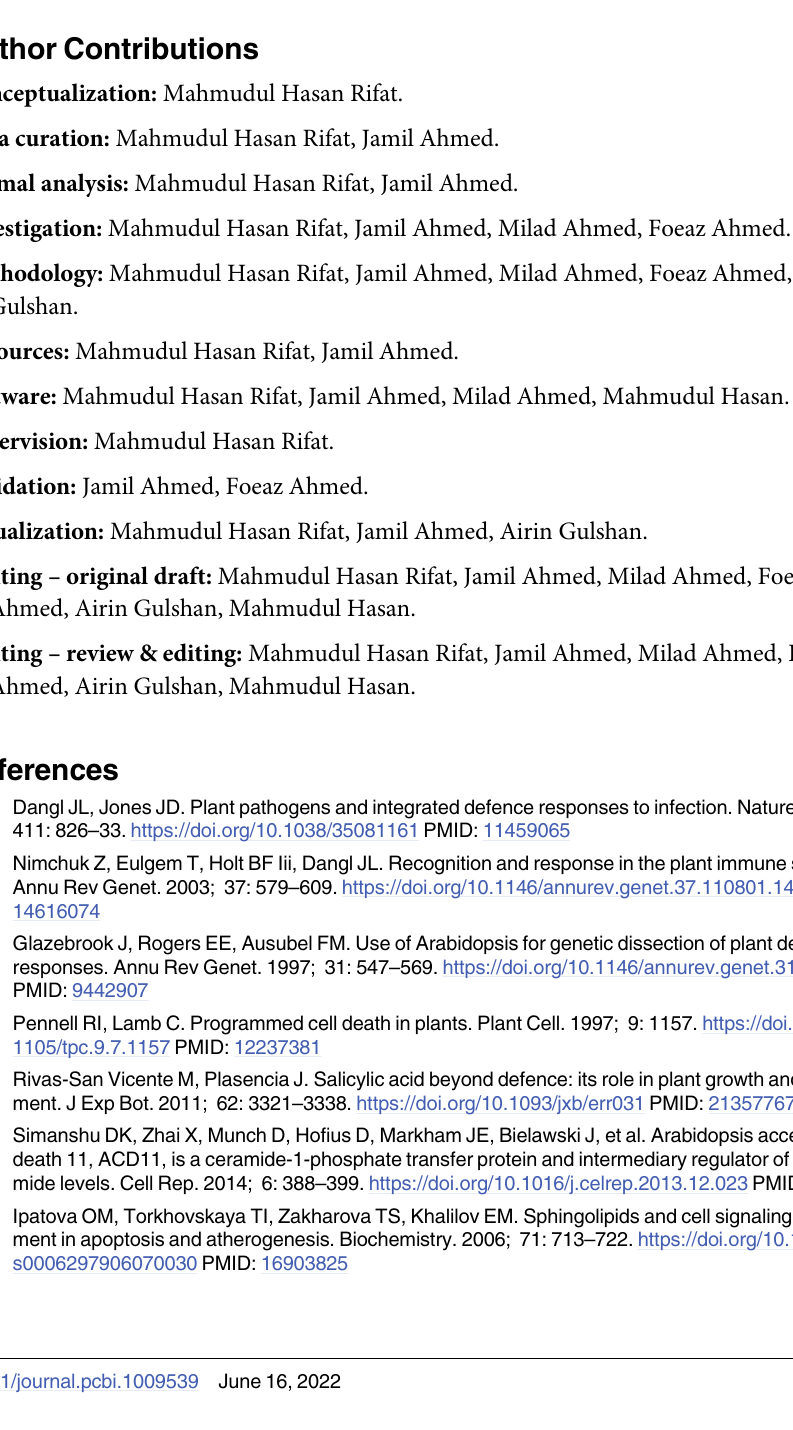
S17 Table. Potential domain information of ACD11. S18 Table. Ramchandra plot, ERRAT and Varify3D